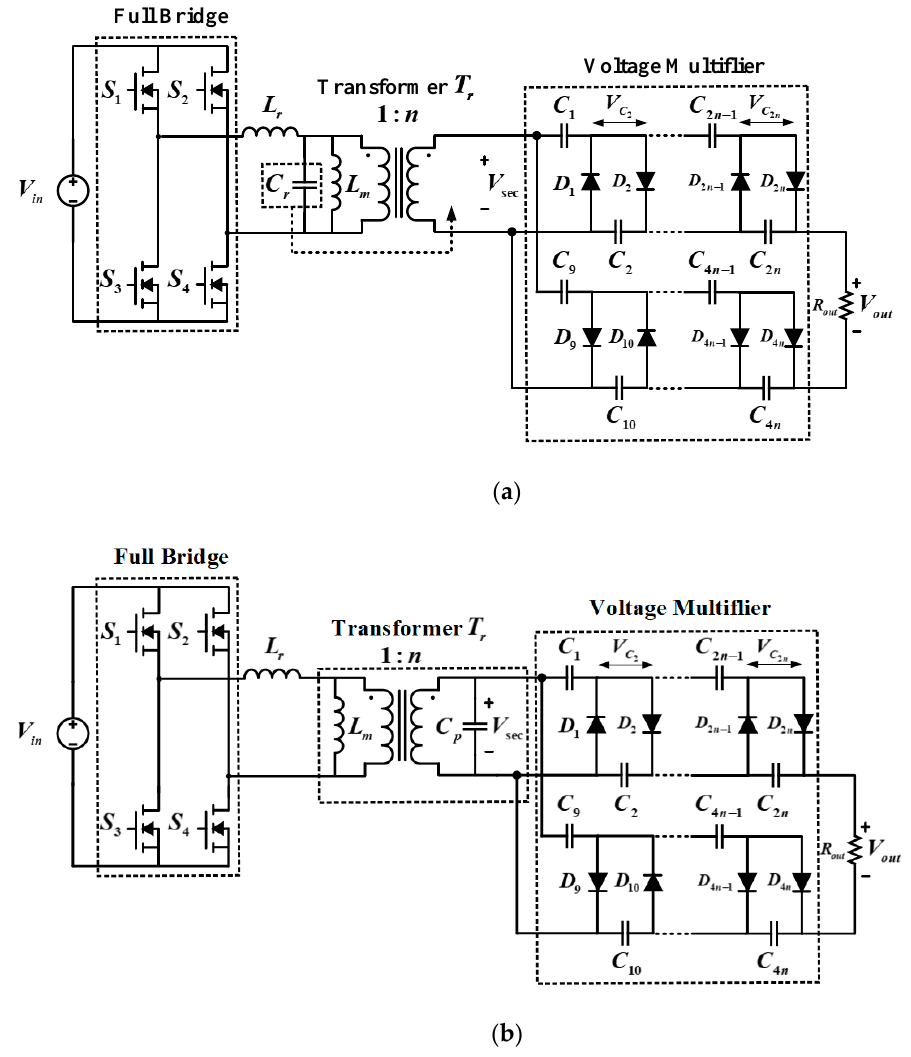
Figure 1. System structure of the parallel resonant converter applied with a voltage multiplier: ( a ) conventional system structure; ( b ) proposed system structure.